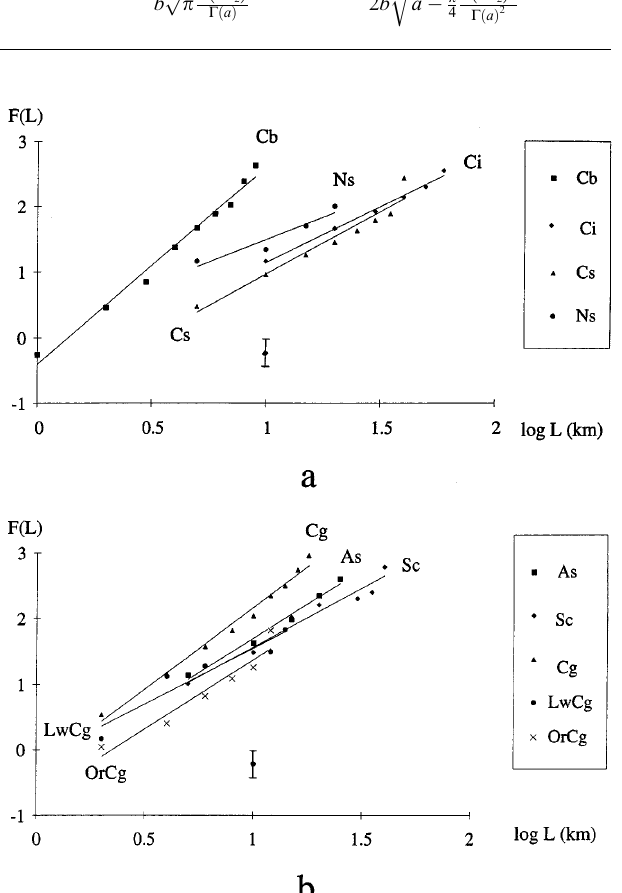
Fig. 1a, b. Cumulative frequency distributions of size ( L , in km) and log-normal fitting: a for types Cb, Ci, Cs, Ns; b for types As, Sc, Cg, LwCg, OrCg. The error bar displayed is calculated using Eqs. (16) and (3). Its magnitude is roughly constant in the range of